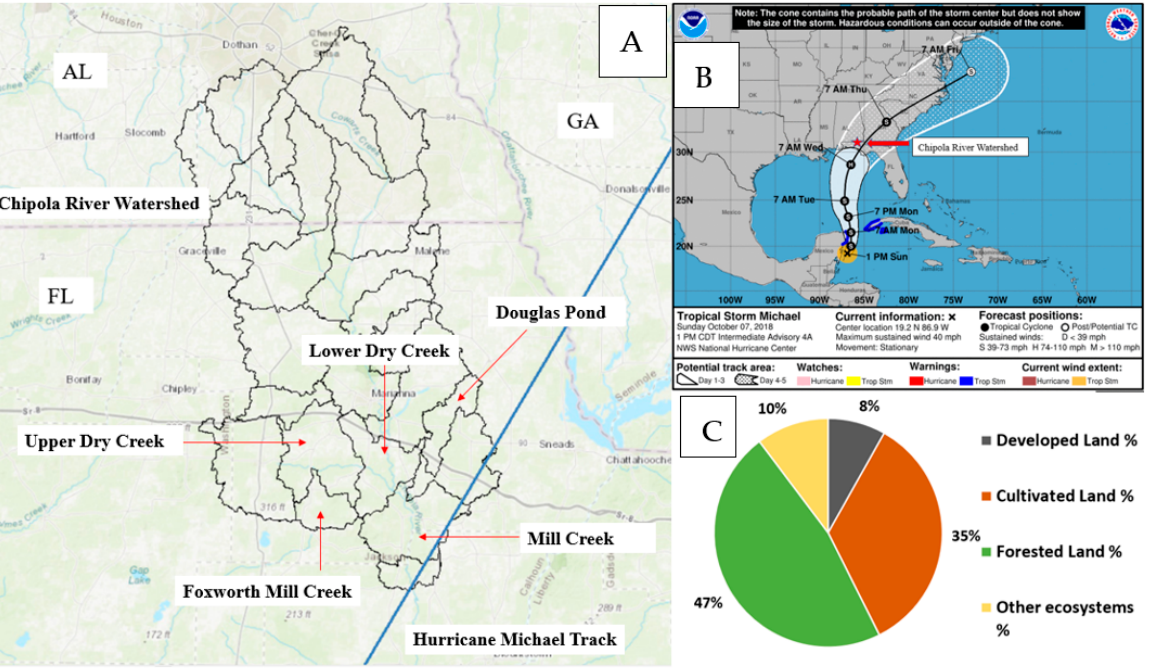
Figure 1. Location of Chipola River watershed ( A ) in association with hurricane track (blue line), hurricane track and categories over time ( B ) (https://www.weather.gov/tae/HurricaneMichael2018) (accessed on 15 February 2022), and breakdown of land use and land cover of the study watershed ( C ).